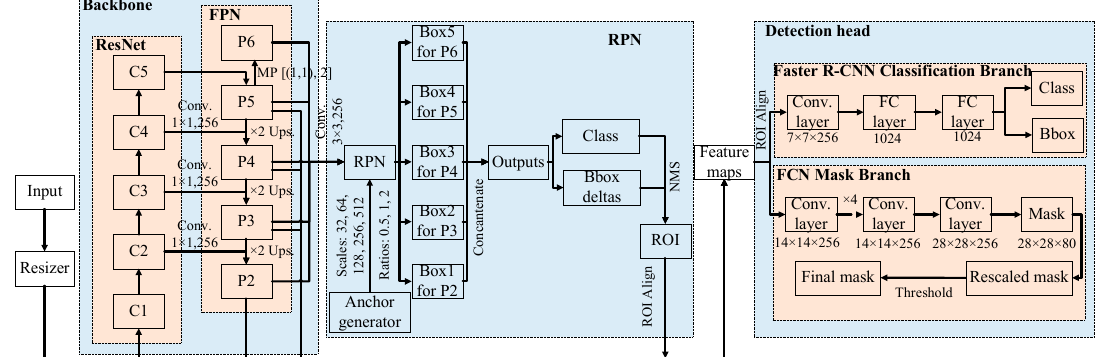
Figure 2. Network structure of mask region-based convolutional neural network (mask R-CNN). ResNet is a residual network; FPN is a feature pyramid network; RPN is a region proposal network; ROI is region of interest; NMS is non-maximum suppression; FC layer is fully-connected layer; Bbox is bounding box; FCN is fully-connected network; C1–C5 are convolutional stages 1 to 5 in the ResNet; P2–P6 are feature maps in the FPN; Box1–Box5 are proposed boxes with various scales and ratios after the RPN; Conv. 1 × 1,256 is the convolution with the kernel size of (1, 1) and depth of 256; MP [(1, 1), 2] is max pooling with the size of (1, 1) and stride of 2; × 2 Ups. is upsampling with the size of (2, 2); Conv. 3 × 3 × 256 is the convolution with the kernel size of (3, 3) and depth of 256; 7 × 7 × 256 is the size (length of 7, width of 7 and depth of 256) of convolution layers; 1024 is the number of neurons in the FC layer; 14 × 14 × 256 is the size (length of 14, width of 14 and depth of 256) of convolution layers; × 4 is the repeated operations of the previous layer for 4 times; 28 × 28 × 256 is the size (length of 28, width of 28 and depth of 256) of convolution layers; 28 × 28 × 80 are 80 target masks with the size of 28 in length and 28 in